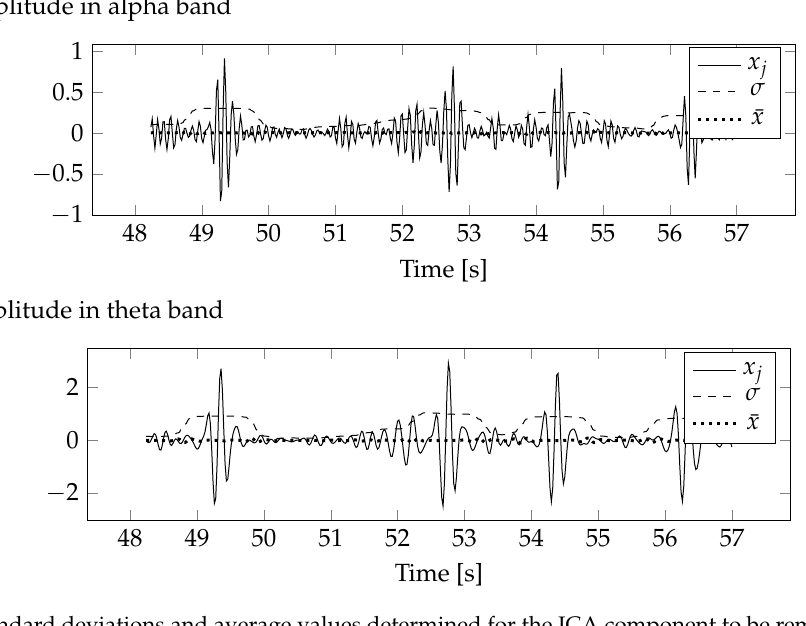
Figure 5. Standard deviations and average values determined for the ICA component to be removed.